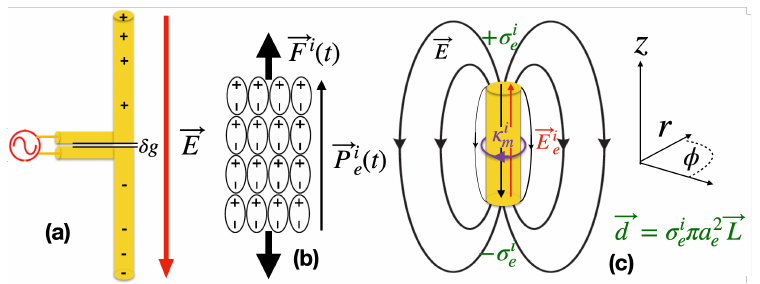
Figure 1. ( a ) A free charge active Hertzian dipole antenna, ( b ) an active dipole bound charge nanogenerator. Both can be modelled by a voltage source with a capacitive output impedance [1] . ( c ) The equivalent macroscopic model of the active dipole with oppositely polarity surface